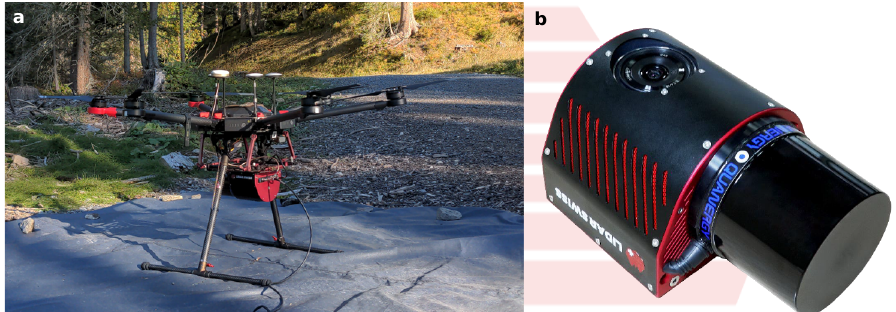
Figure 3. Instrumentation: ( a ) the UAV (DJI Matrice 600) that was used in this study with the mounted LiDAR system; ( b ) the LiDAR system (Nano M8, LidarSwiss GmbH).